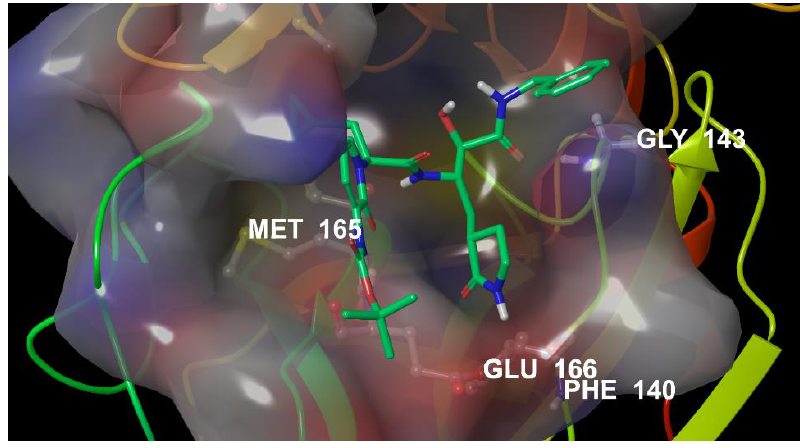
Figure 2. 3D binding site of SARS-CoV-2 M PRO in complex with inhibitor 13b (PDB id 6Y2F).